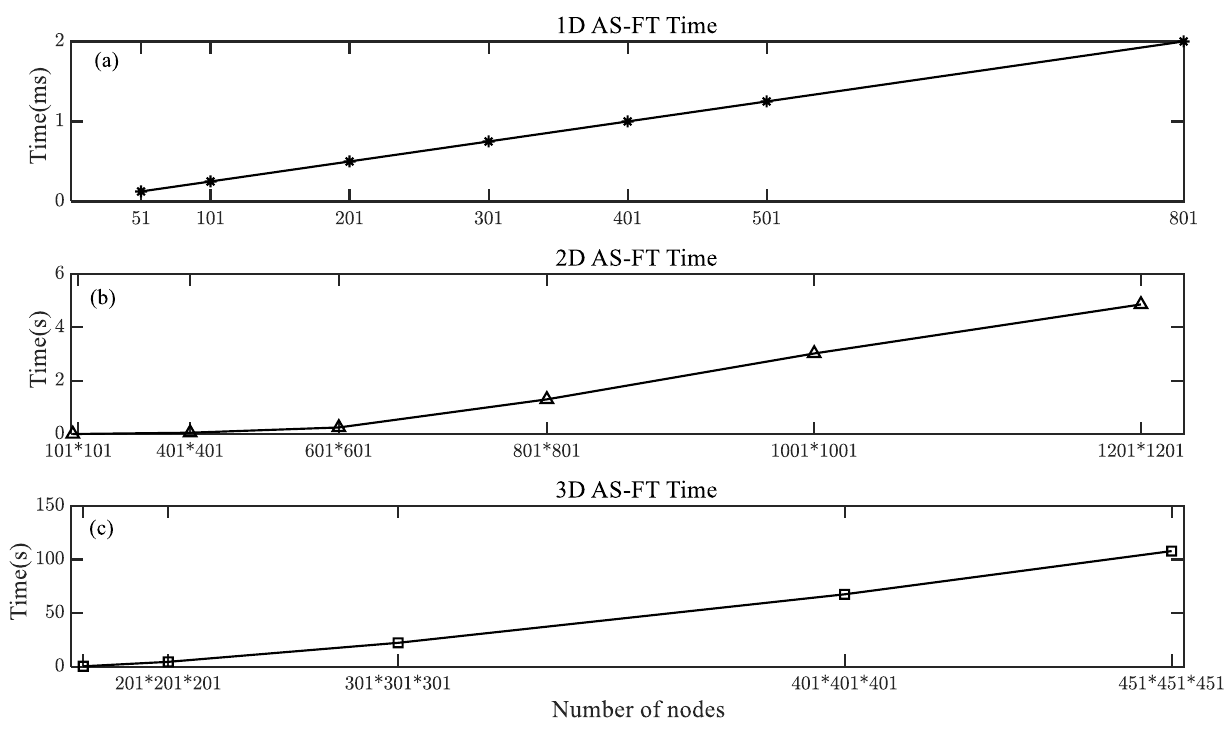
Figure 4. Time required for one transformation of 1D, 2D, and 3D AS-FT. ( a ) Calculation time of 1D AS-FT under different node numbers. ( b ) Calculation time of 2D AS-FT under different node numbers. ( c ) Calculation time of 3D AS-FT under different node